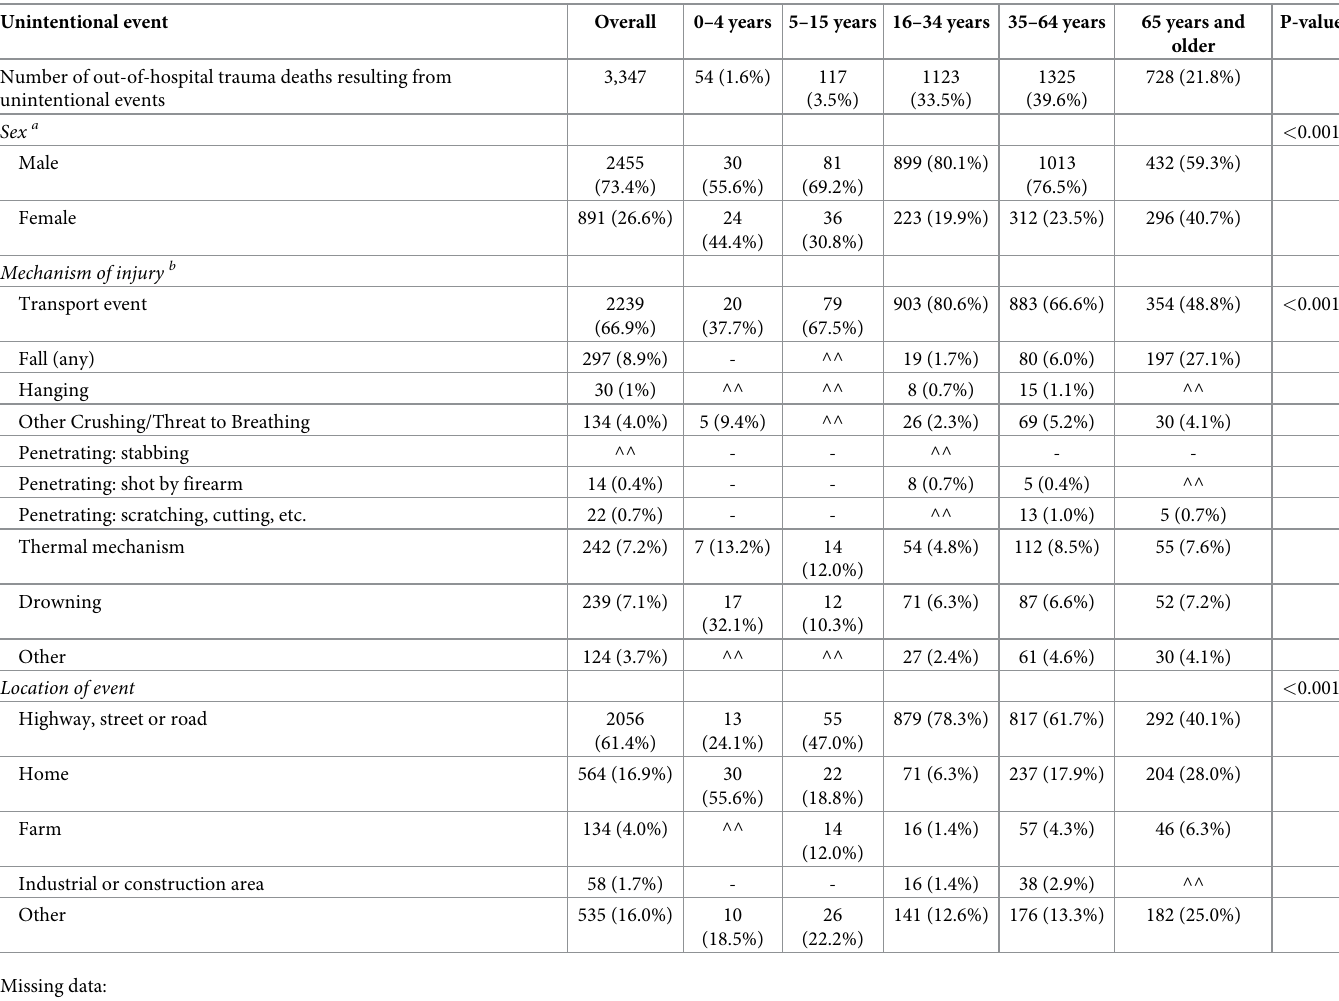
Table 4. Cause of injury and location of event of cases by age group for out-of-hospital deaths resulting from unintentional events. Unintentional